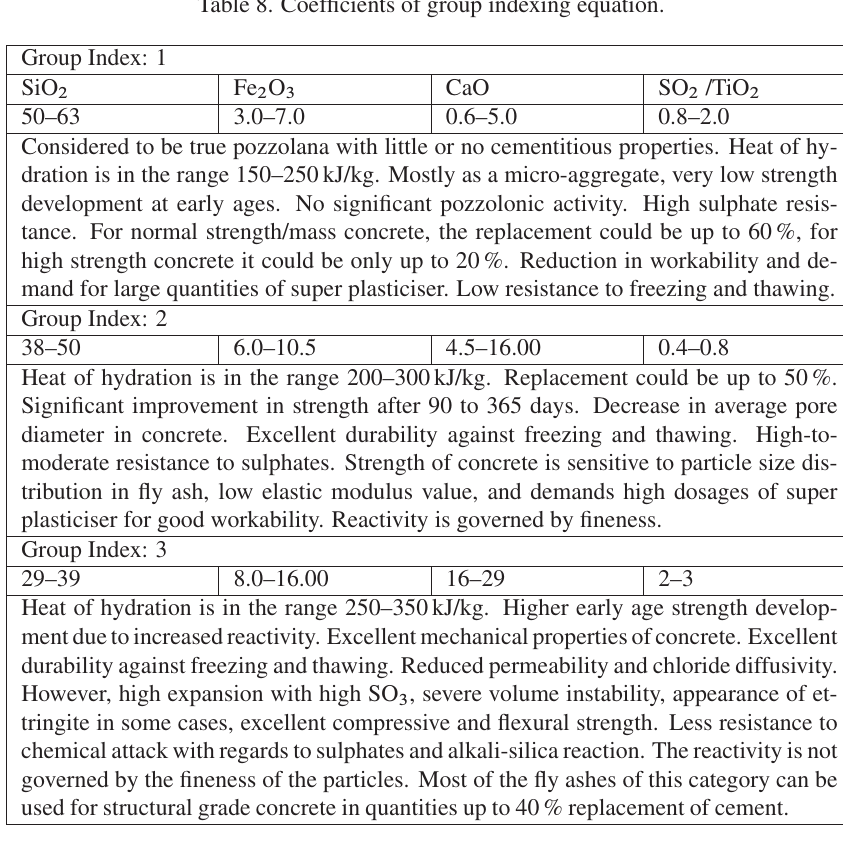
Table 9. Groups and their